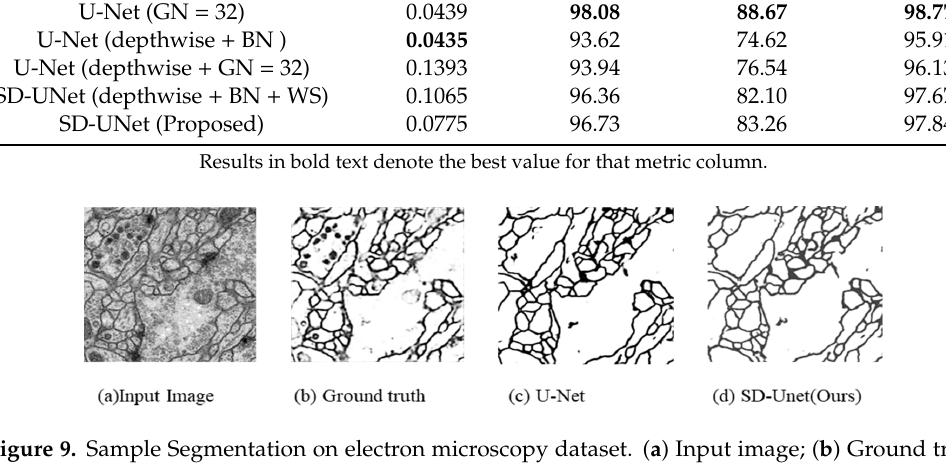
Table 3. Performance comparison between U-Net and SD-UNet.